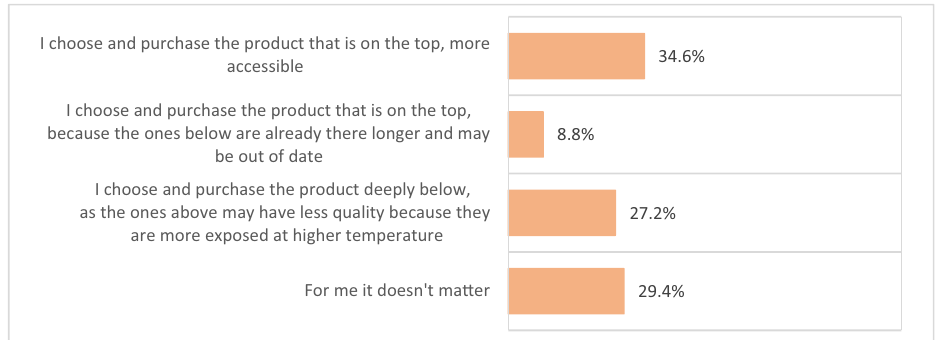
Figure 8: Results for the question: “ Select the statement that best represents your behavior when choosing and/or purchasing frozen food products from horizontal RDC ” .